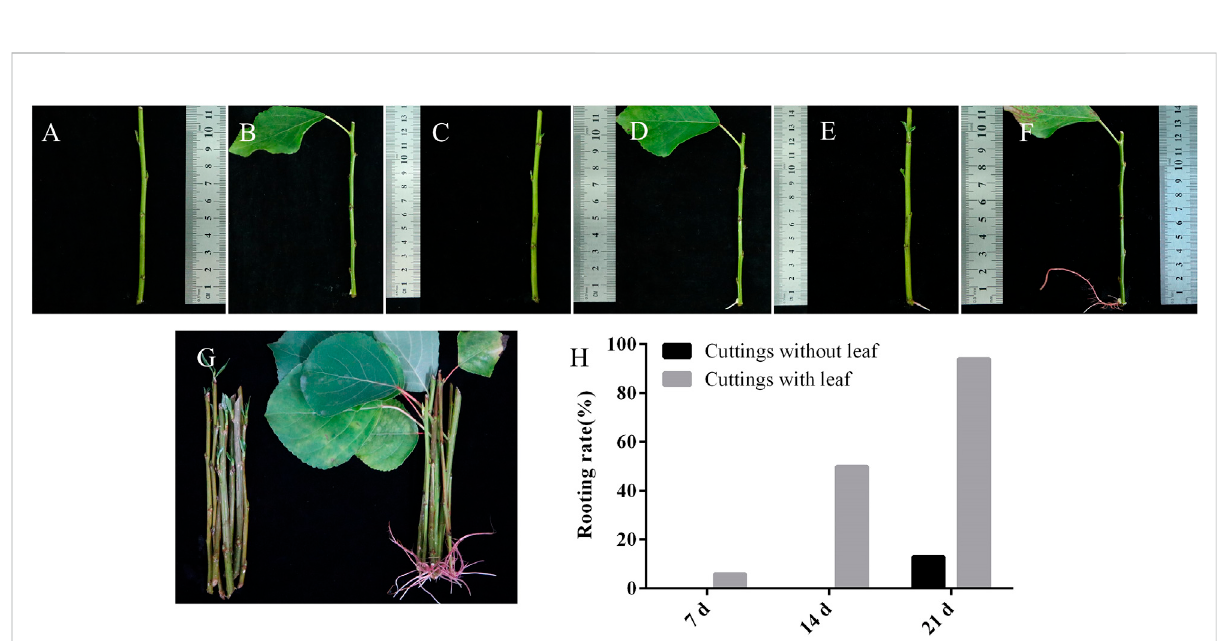
FIGURE 7 Adventitious root formation in P. xiaohei cuttings. (A,C,E) P. xiaohei cuttings without leaf were treated with water for 0, 14, and 21 days, respectively. (B,D,F) P. xiaohei cuttings with leaf were treated with water for 0, 14, and 21 days, respectively. (G) P. xiaohei cuttings without leaf and with leaf were treated with water for 21 days. (H) Rooting rates of P. xiaohei cuttings. Values are from 30 independent cuttings.